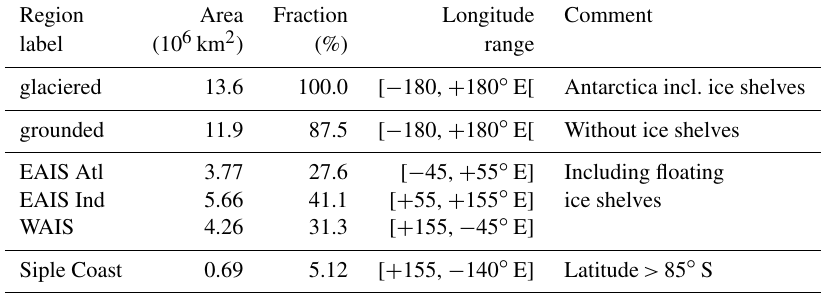
Table 5. Defined areas as part of our diagnostic. The fraction is computed relative to “glaciered”. Figures 1, 4, and 5 depict these areas. Region Area Fraction